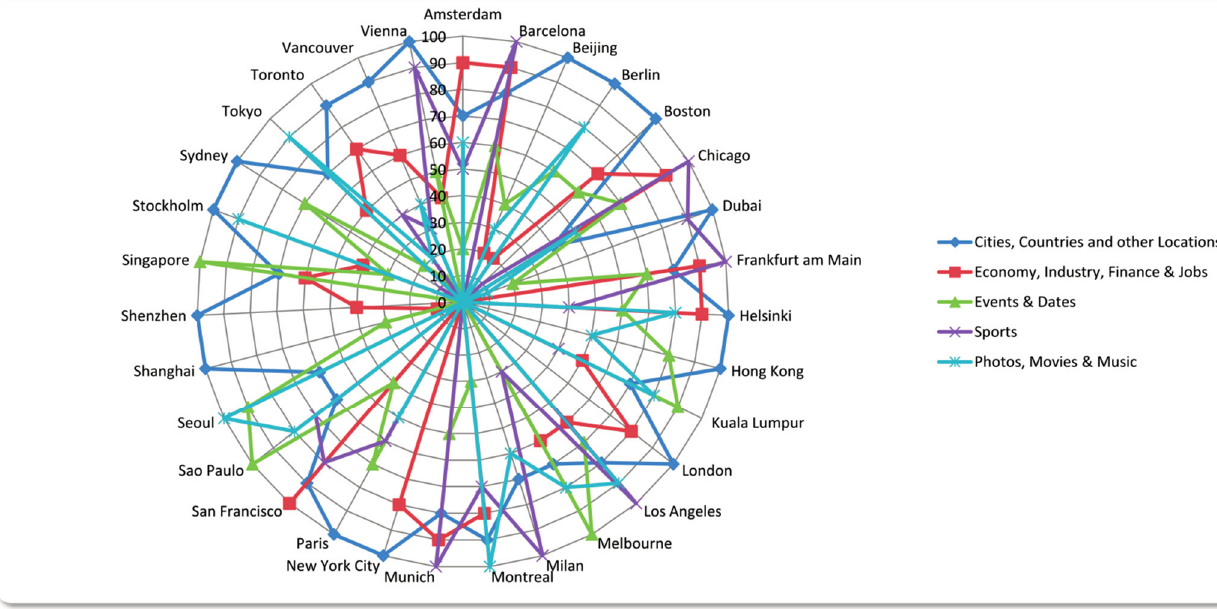
Figure 5. The most important topics in tweets